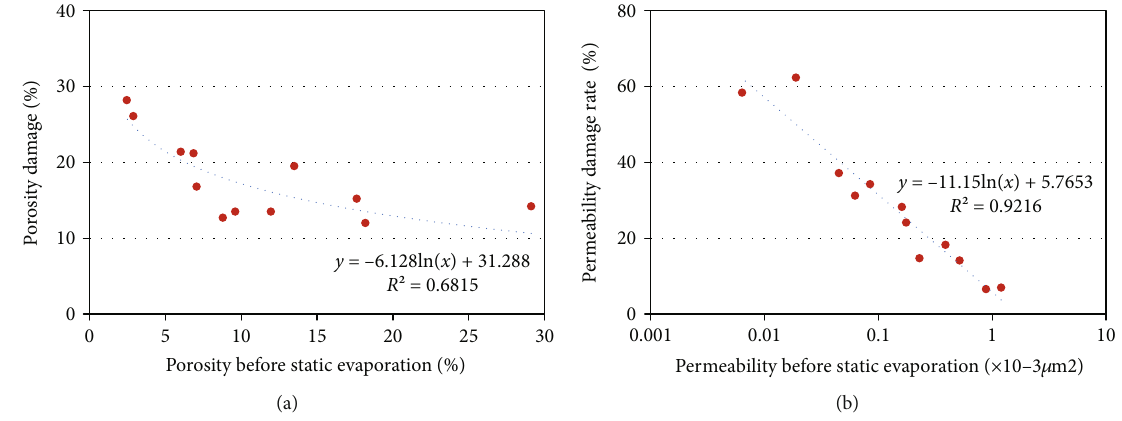
Figure 10: E ff ects of salt precipitation on the porosity and permeability of intersalt dolomitic